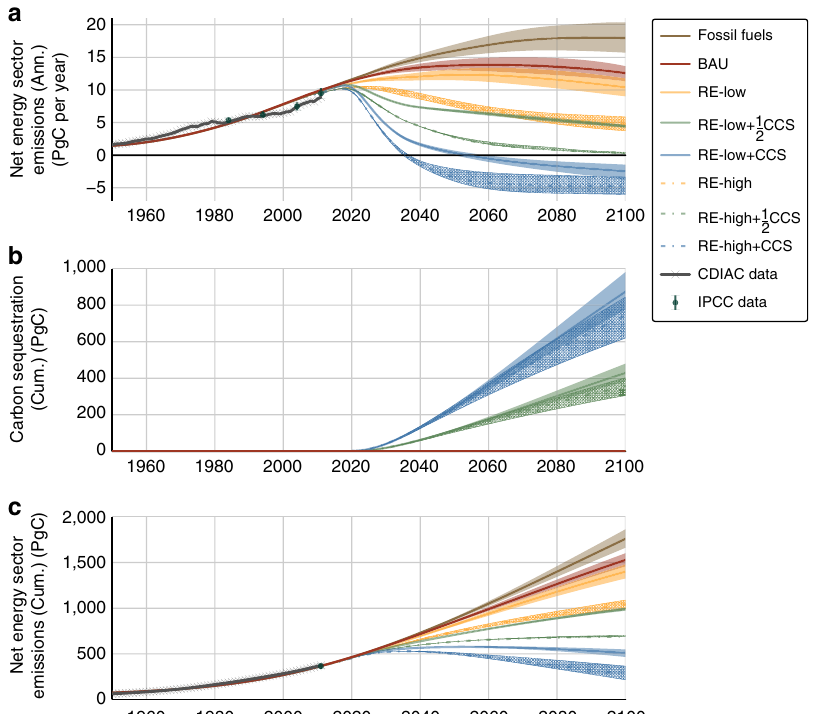
Figure 3 | Energy sector carbon emissions. ( a ) Annual net emissions (PgC per year); ( b ) cumulative emissions mitigation from CCS (PgC); ( c ) cumulative net emissions (PgC). Sources of historical data in a , c : IPCC AR5 (green bars) 3 and CDIAC (grey series) 33